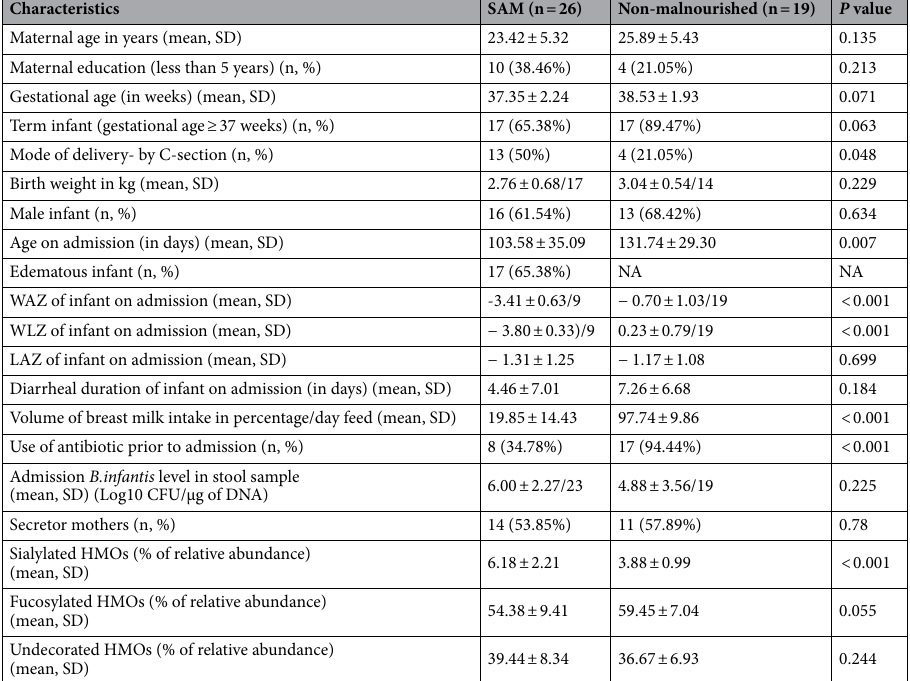
Table 1. The baseline characteristics of SAM and non-malnourished young infants and their mothers. HMOs, human milk oligosaccharides; WAZ, weight for age z score; WLZ, weight for length z score; LAZ, length for age z